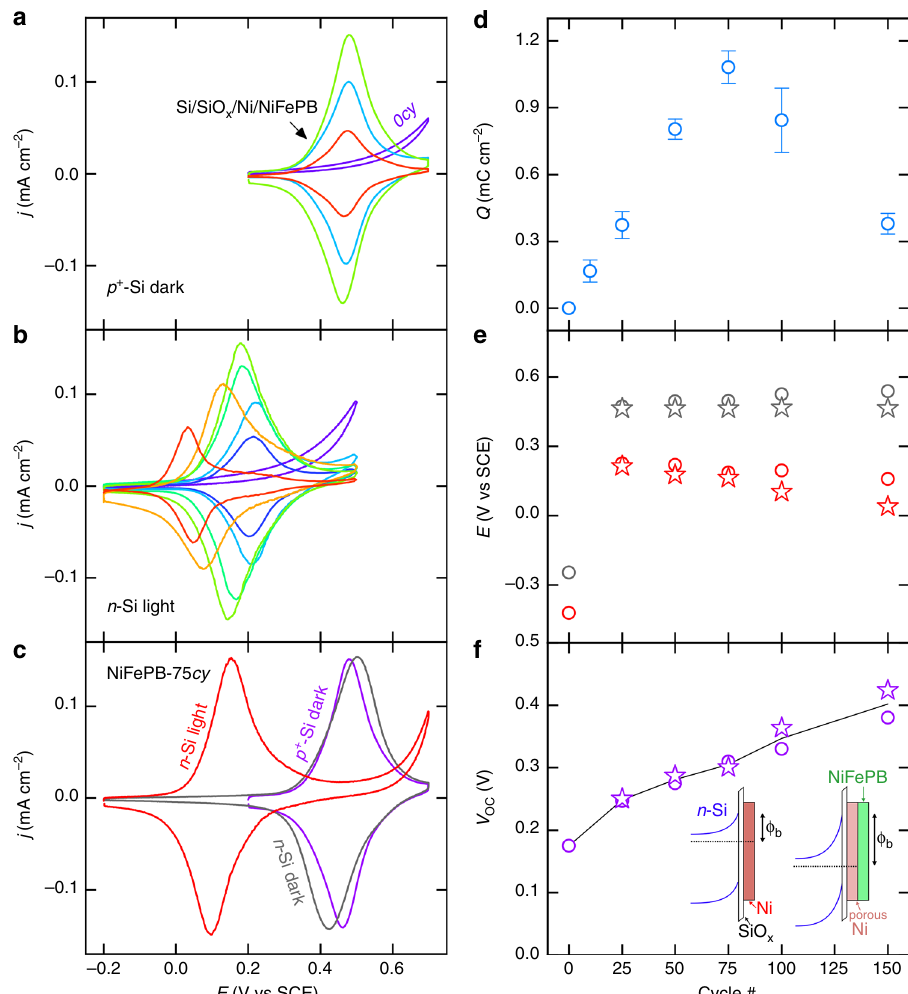
Fig. 3 Electrochemistry and photoelectrochemistry of Si/SiO x /Ni/NiFePB anodes. a , b CVs recorded a in the dark on p + -Si/SiO x /Ni/NiFePB and b under simulated sunlight on n -Si/SiO x /Ni/NiFePB, prepared with different number of cycles ((purple) 0cy , (dark blue) 10cy , (light blue) 25cy , (cyan) 50cy , (light green) 75cy , (yellow) 100cy , and (red) 150cy ). c CVs recorded in the dark on (purple) p + -Si/SiO x /Ni/NiFePB- 75cy and (gray) n -Si/SiO x /Ni/NiFePB- 75cy and under simulated sunlight on (red) n -Si/SiO x /Ni/NiFePB- 75cy . d Integrated average charge of the oxidation peak for Si/SiO x /Ni/NiFePB anodes as a function of the number of cycles (the errors bars represent the standard deviation of at least four independent measurements). e Values of (disks) OCP and (stars) E 0 ′ measured in the dark (gray) and under simulated sunlight (red) on n -Si/SiO x /Ni/NiFePB as a function of the number of cycles. f Values of V E 0 ′ measurements on n -Si/SiO oc determined by (purple disks) OCP and (purple stars) x /Ni/NiFePB as a function of the number of cycles. The black curve represents the variation of the average value. Inset: schematic band diagrams of left) n -Si/SiO x /Ni and right) n -Si/SiO x /Ni/NiFePB junctions in the dark, showing the increasing of the barrier height ( ϕ b ) after modi fi cation. All measurements were performed in Ar-saturated 1 M KCl, the CVs were recorded at 10 mV s −